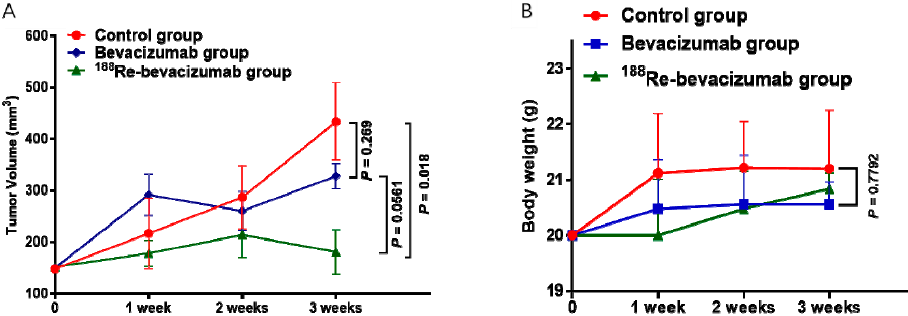
Figure 5. The alteration of tumor volumes and body weight. ( A ) Tumor volume are effectively inhibited in 188 Re-bevacizumab group; ( B ) No significant weight loss is occurred in 88 Re-bevacizumab group.